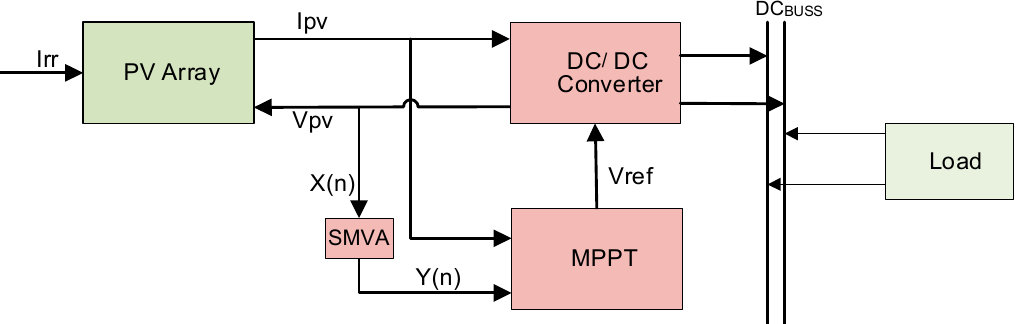
Figure 27. Simple moving voltage average configuration. Abbreviations: SMVA, simple moving voltage average.